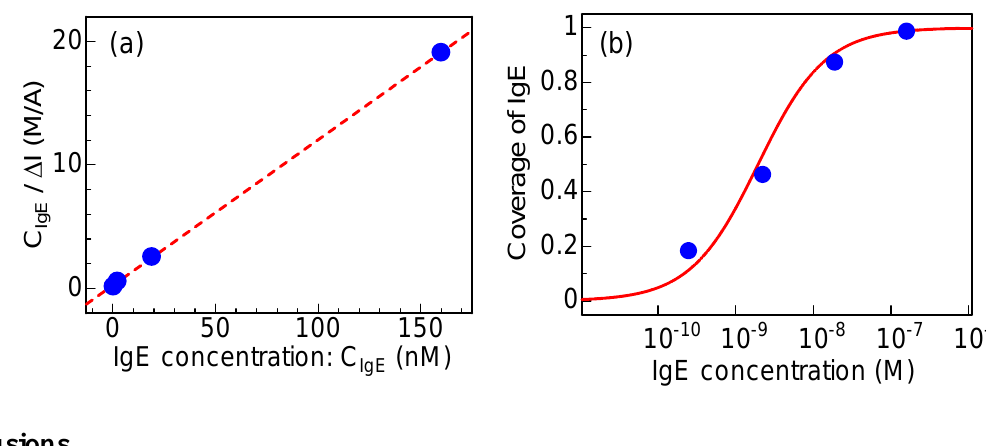
Figure 6. (a) IgE concentration / amount of net drain current as a function of IgE concentration. (b) Coverage of IgE as a function of IgE